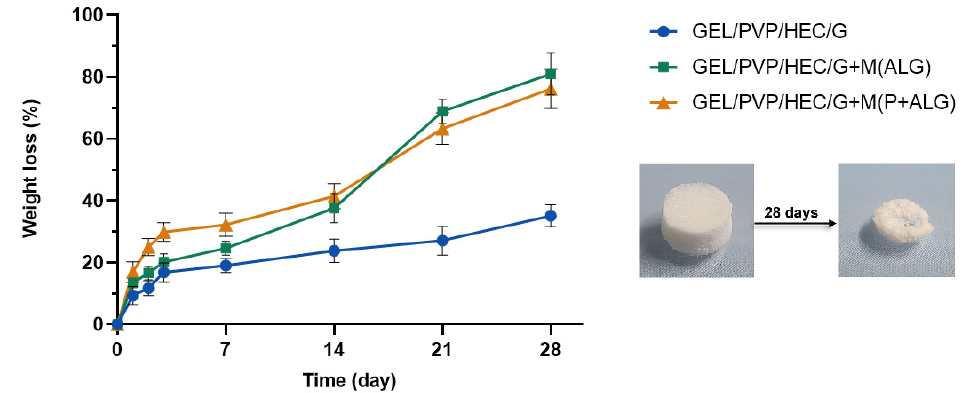
Figure 6. The weight loss during the degradation of the prepared matrices containing the microparticles with the surfactant.